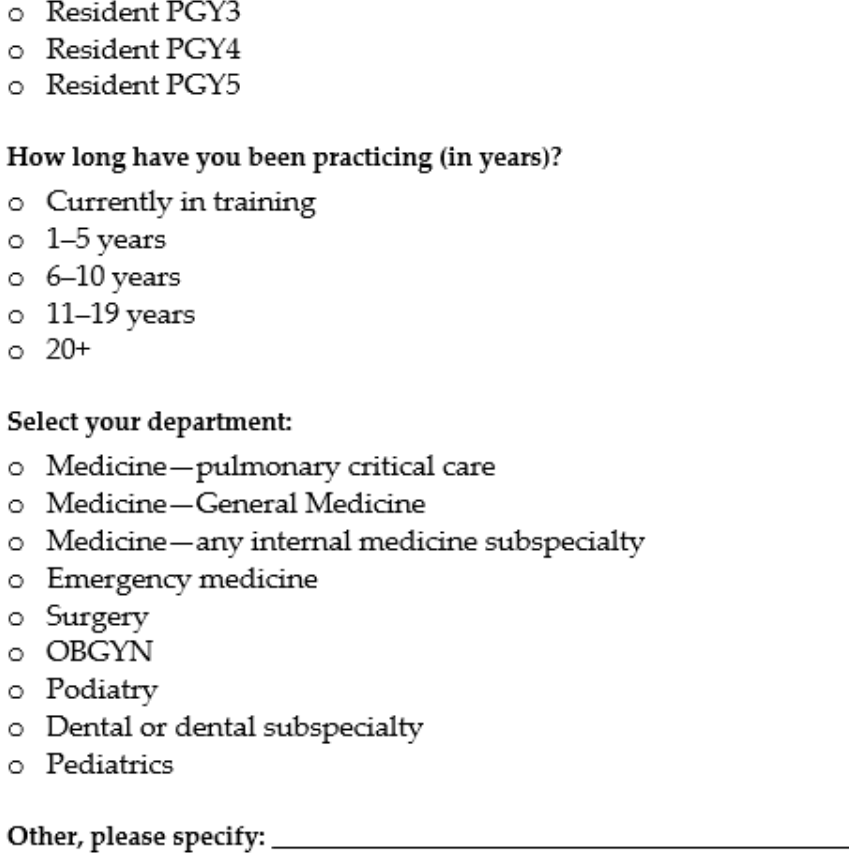
Figure A1. NYPQ Frontline Well-Being and Needs Assessment Survey.